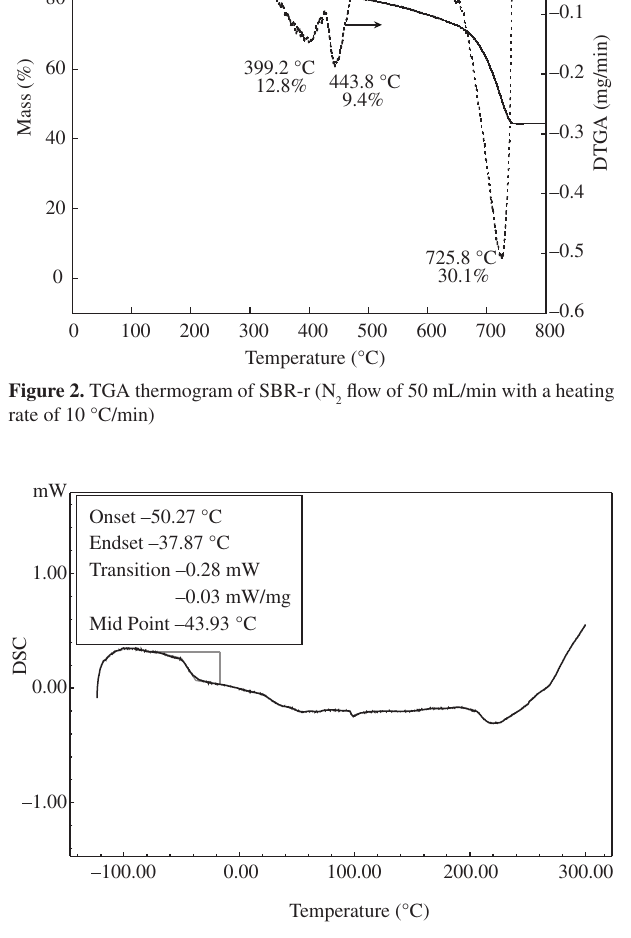
Figure 3. DSC thermogram of SBR-r (N rate of 10